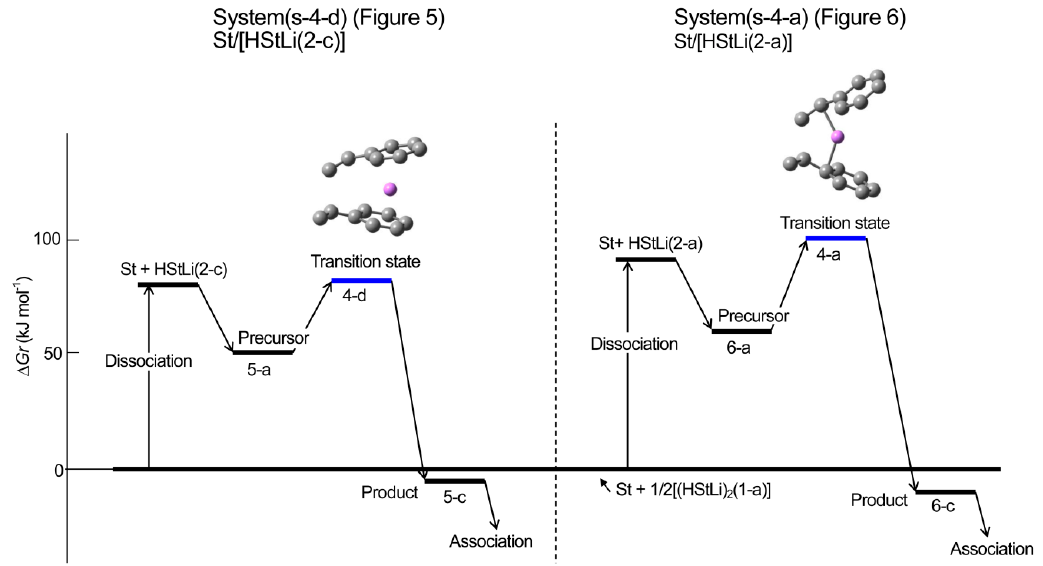
Figure 8. Free energy changes for the addition of styrene to HStLi in the gas phase.